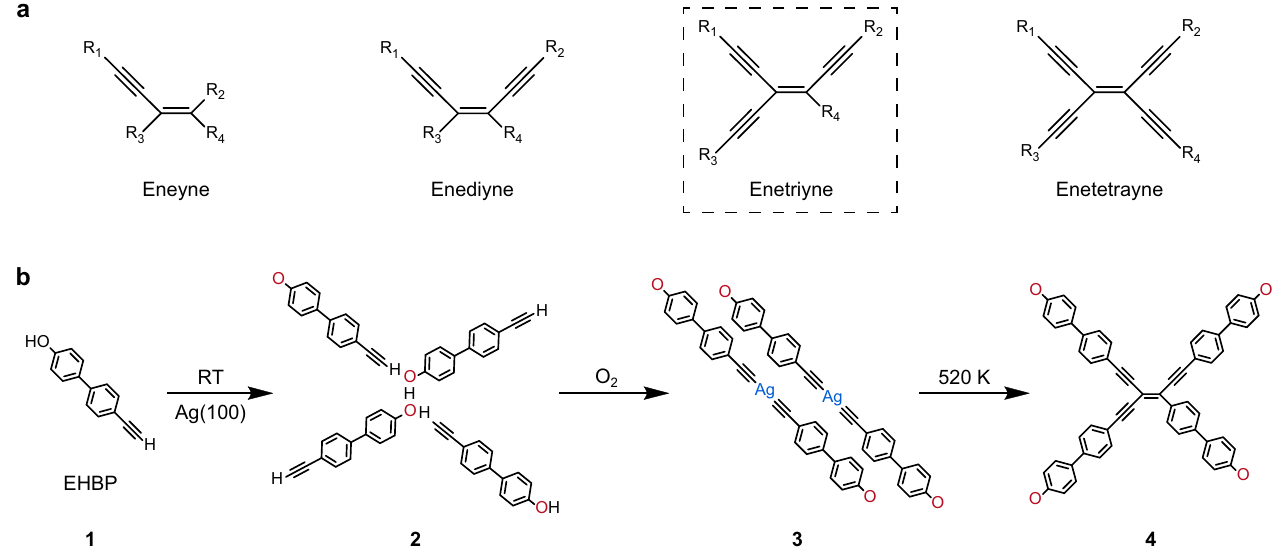
Fig. 1 | Scheme of enynes and reaction pathway. a The enyne family features elements with different electron-rich C-C bonding con fi gurations. The marked ene- triyne species is the main product obtained by the on-surface synthesis strategy developedinthiswork. b Schematicillustrationshowingthechemicaltransformations